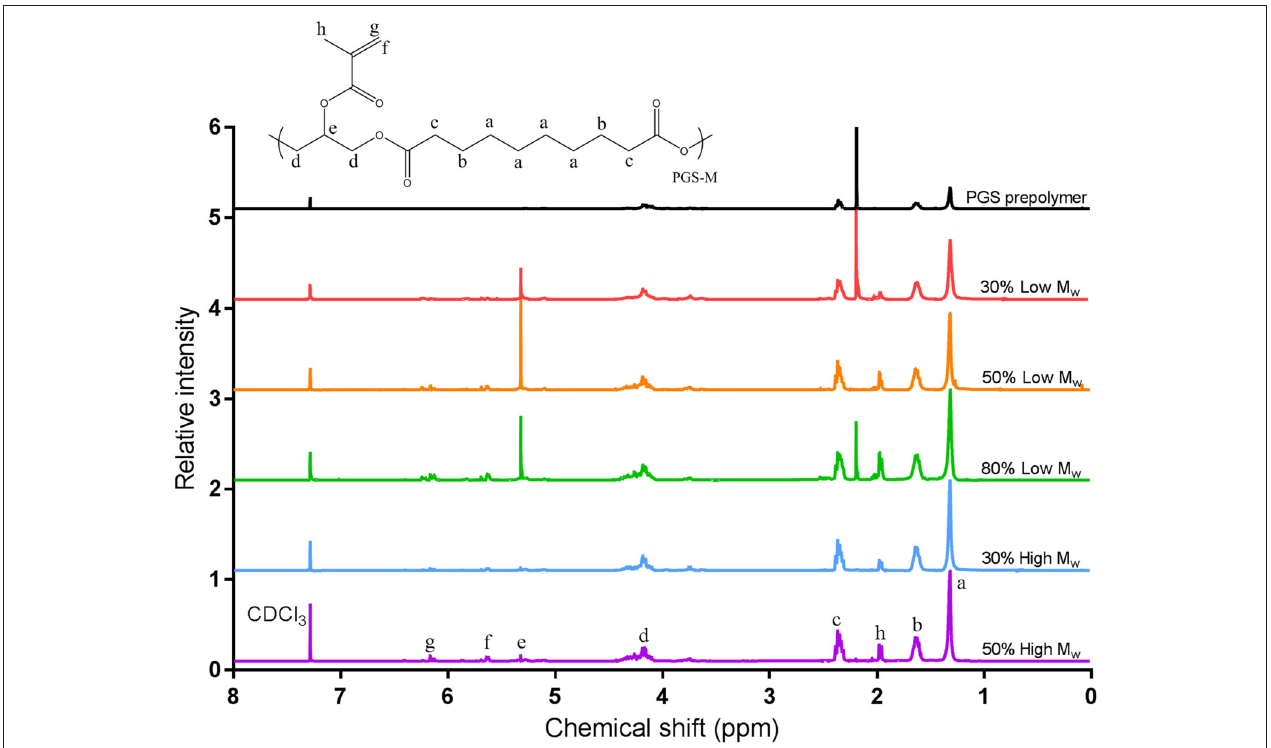
FIGURE 4 | Proton NMR analysis of PGS and PGS-M prepolymers at varied DM (30, 50, and 80%) and Low and High M w . The different hydrogen environments present in the prepolymer are labeled a–h. Peaks at 1.9, 5.6, and 6.2 ppm for PGS-M samples are associated with the methacrylate group (hydrogen environments f, g, and h). Comparing the integrals of these peaks with those of the methylene groups of sebacic acid (1.3 ppm, hydrogen environment a) allowed the DM to be